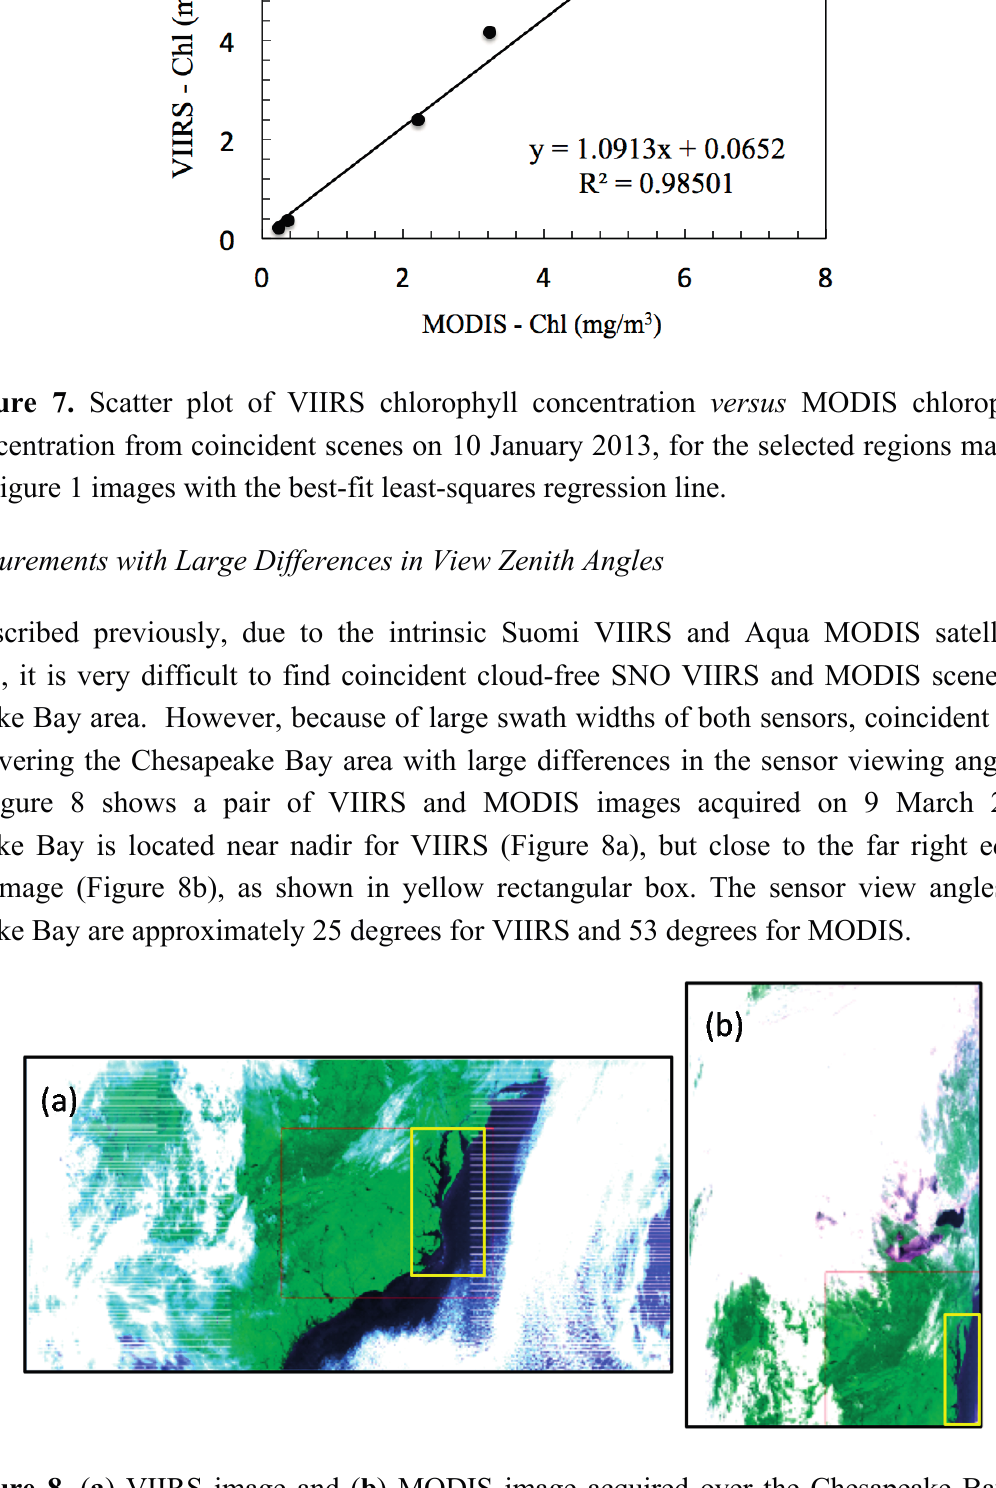
Figure 8. ( a ) VIIRS image and ( b ) MODIS image acquired over the Chesapeake Bay on 9 March